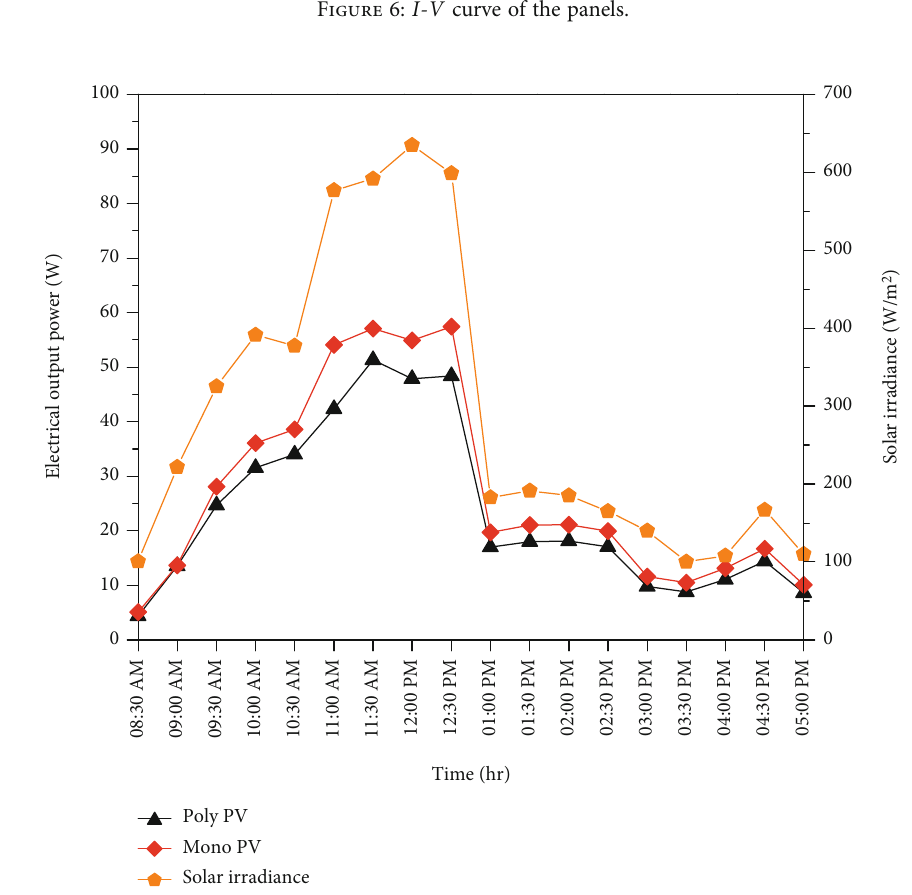
Figure 7: Electrical output power with respect to time and solar